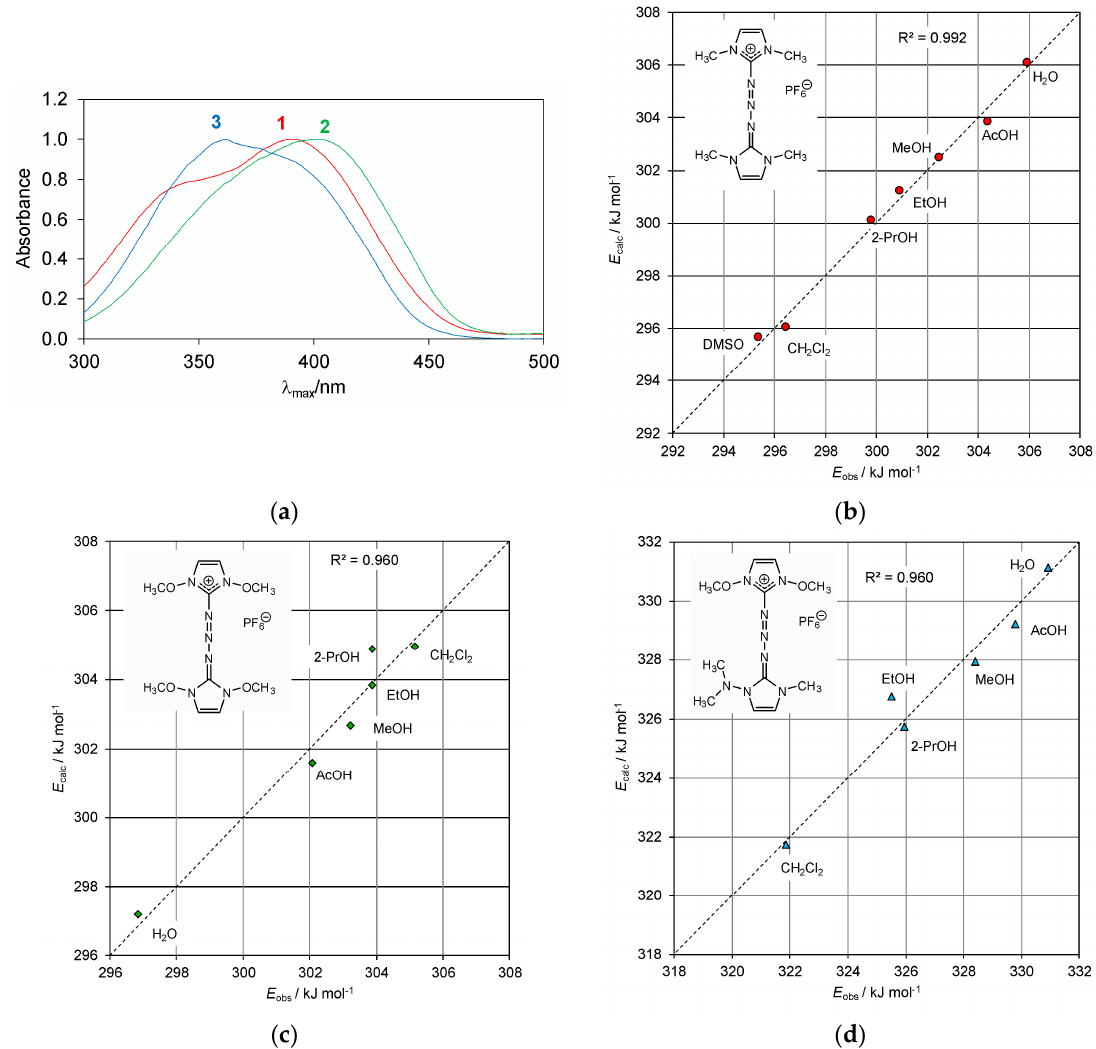
Figure 5. ( a ) Normalized UV-Vis spectra of triazenes 1 – 3 in H 2 O. ( b – d ) correlation of observed vs. calculated transition energies of triazenes 1 – 3 in polar solvents.